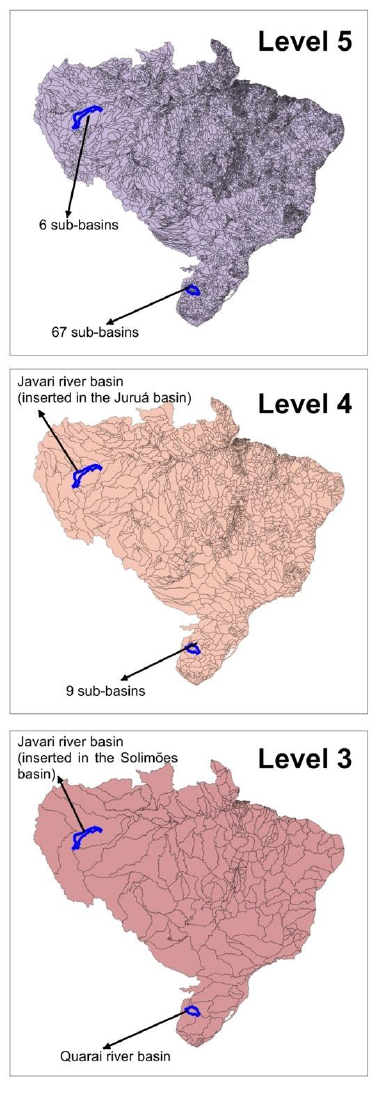
Figure 9. Brazilian Ottobacias (levels 5, 4, and 3) and case study basins. Generally, the analyses indicate that the average size of polygons does not decrease proportionally as the level of the basins rises. As a result, it is impossible to find a level that accurately identifies the analyzed basins. The Javari/Yavarí River Basin appears over- sized in Peru ’ s cross-border data (Figure 10), indicating that it is included in a polygon with other basins. These problems may eventually lead to conflicting border limits, which can be identified as mismatched borders in the overlapping national databases.